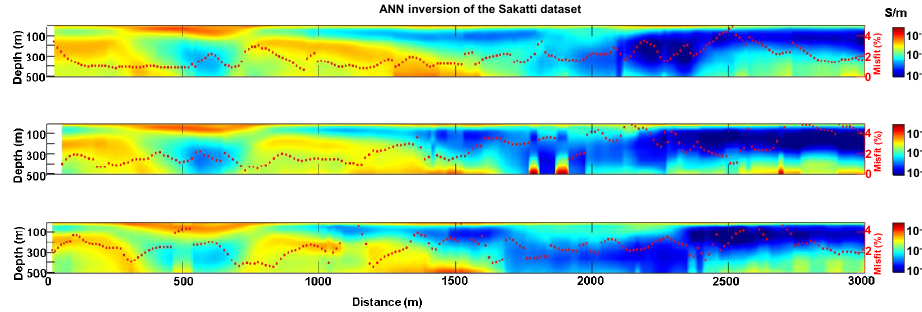
Figure 6. The ANN inversion of the field data.